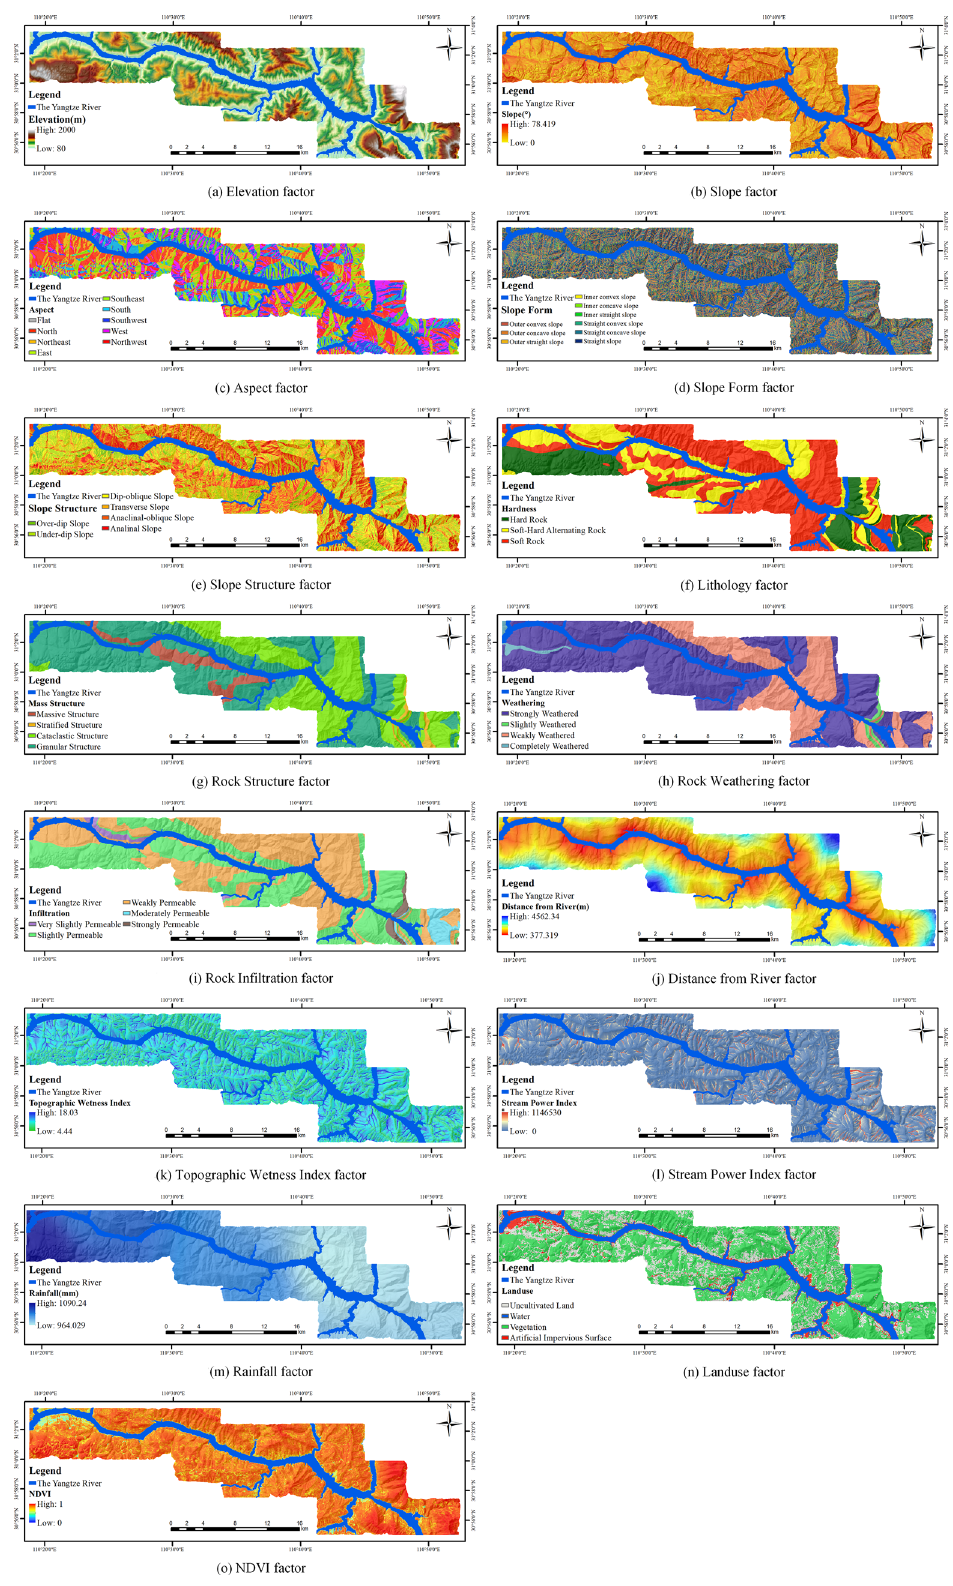
Figure 8. LSM factors in the study area (Drawn with ArcGIS 10.8 software, and the URL is: https:// www. esri. com/ en- us/ arcgis/ about- arcgis/ overv